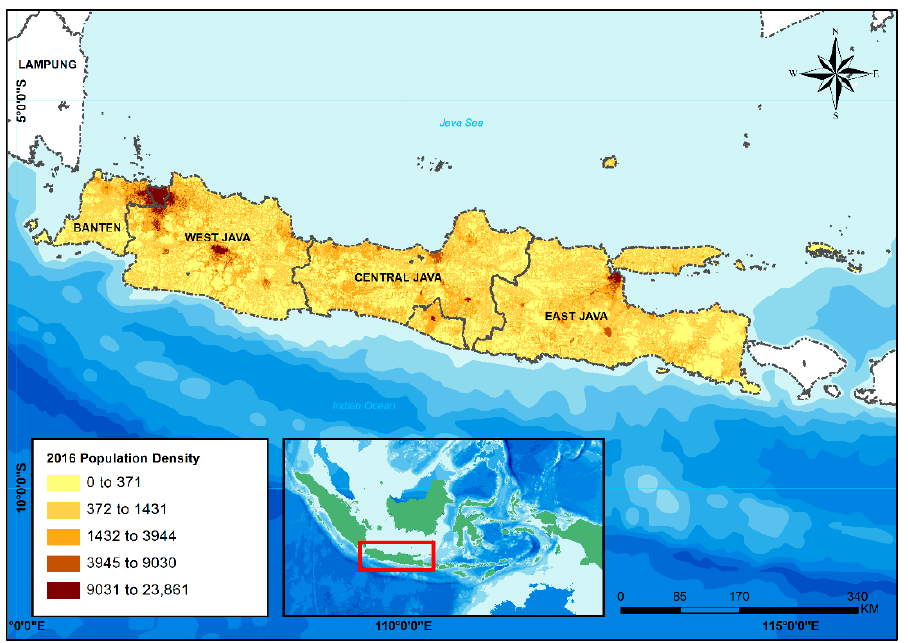
Figure 1. Population distribution of Java Island in the year 2016.